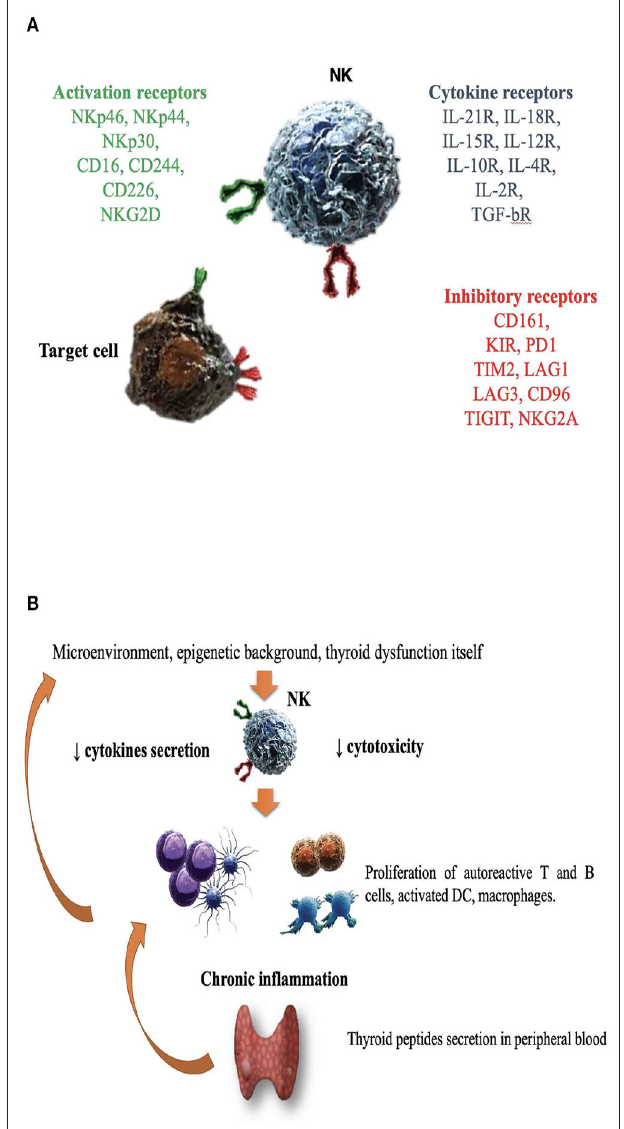
FIGURE 1 | The role of natural killer cells in the pathogenesis of Graves’ disease. (A) Enumeration of activating/inhibitory receptors and cytokines receptors, whose signals determined NK cells activity in health and disease. CD, cluster of differentiation; CD16, Fc receptor; CD244, non MHC biding receptor acting as costimulatory ligand for NK cells; CD69, early expressed after NK cell activation; CD96, interacts with nectin and nectin-like proteins; CD161, recognizes the human NKR-P1A antigen; KIR, killer cell immunoglobulin like receptor; LAG1 and LAG3, lymphocyte activation gene 1 and 3; NKp30, NKp44, NKp46, the natural cytotoxic receptors (NCR); NKG2A and NKG2D, natural killer group 2A and 2D; TIGIT, T cell immunoglobulin and ITIM domain; IL (interleukin)-21/18/15/10/12/4/2 R (receptor); TGF-bR, TGF beta receptor family; PD1, programmed cell death protein 1; TIM2, T-cell immunoglobulin and mucin-containing domain 2; (B) Several factors including microenvironment, cytokines milieu, epigenetic background and hyperthyroidism itself might impair NK protective activity. DC, dendritic cells; NK, natural killer cells.